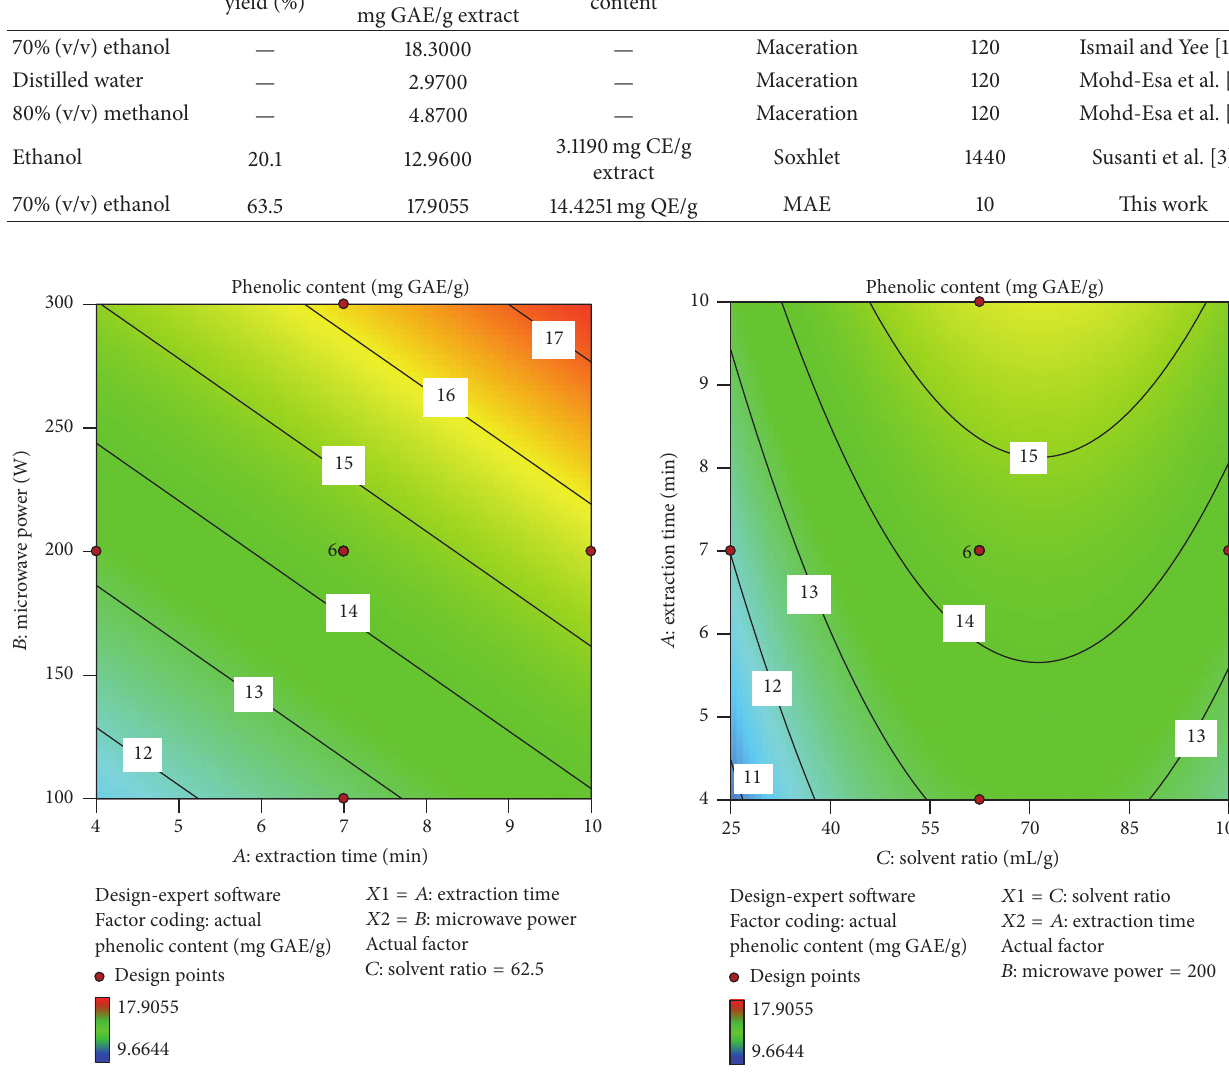
Figure 5: Response surface plot of the interaction between sol- vent/solid ratio ( 𝐶 ) and time ( 𝐴 ) on the total phenolic content of roselle